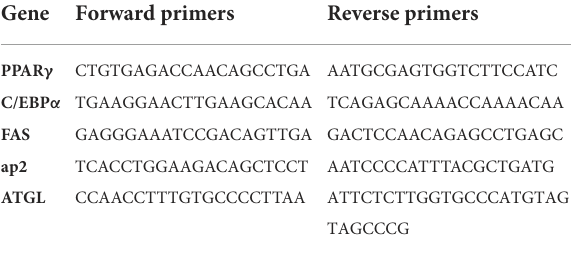
TABLE 1 Primer sequences used for RT-qPCR analysis.